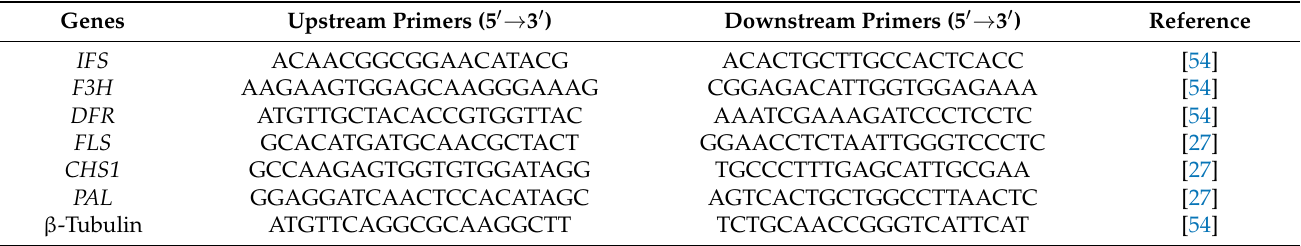
Table 2. Primers for